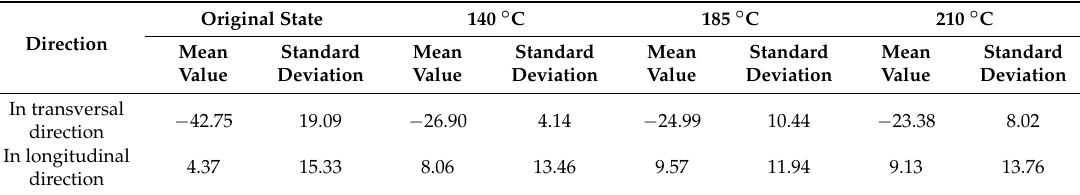
Table 3. Standard deviation and mean value of the average stress at four measuring points before and after TSR at different temperatures. Unit: MPa.